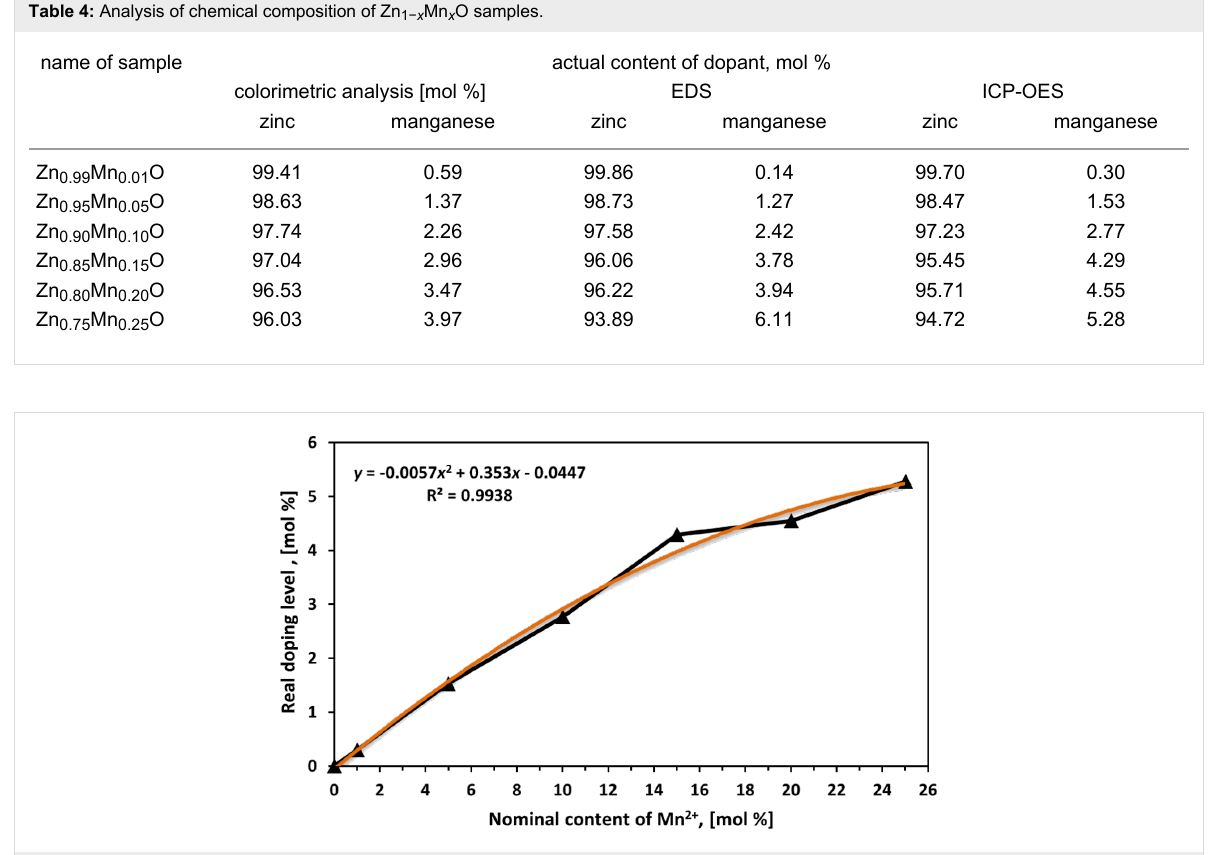
Figure 8: Correlation between the nominal content and the real content of Mn 2+ dopant in ZnO. The results were obtained based on the ICP-OES analysis.